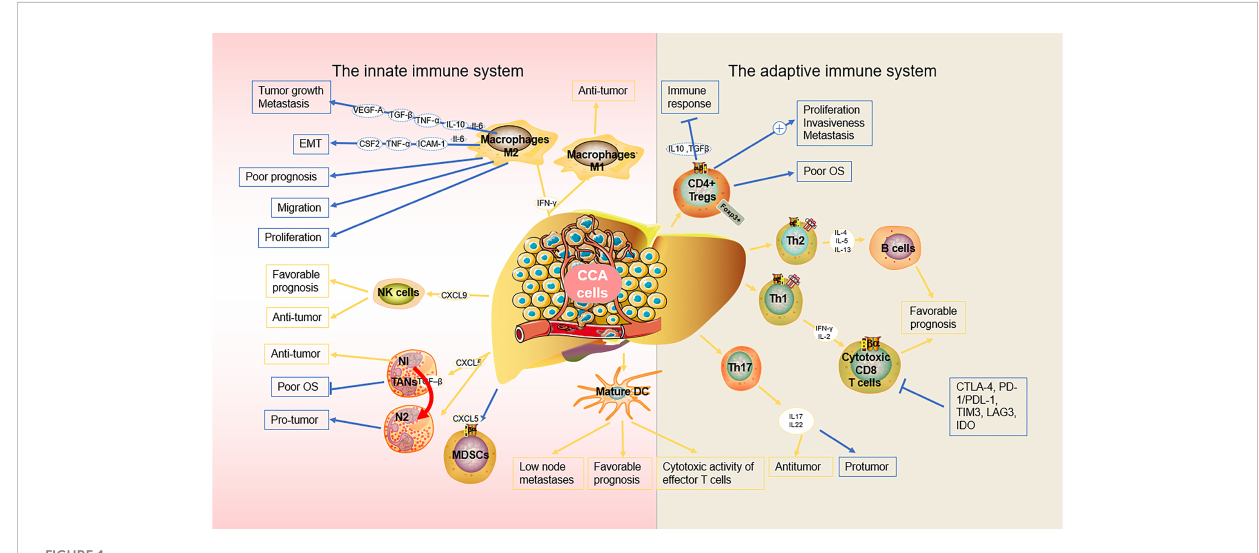
FIGURE 1 Biological role of the main immune components in the microenvironment of CCA.